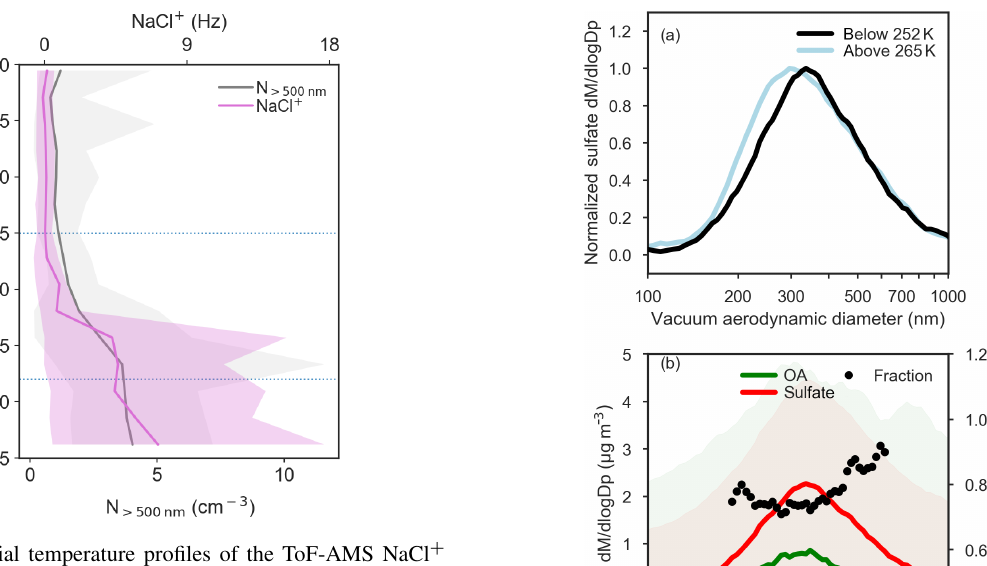
Figure 8. Potential temperature profiles of the ToF-AMS NaCl + signal (top axis), as a qualitative indication of the presence of sea salt aerosol, and N > 500 (bottom axis). The solid lines represent the mean profile for 7–13 April 2015, and shading represents the range of measurements in each potential temperature bin.